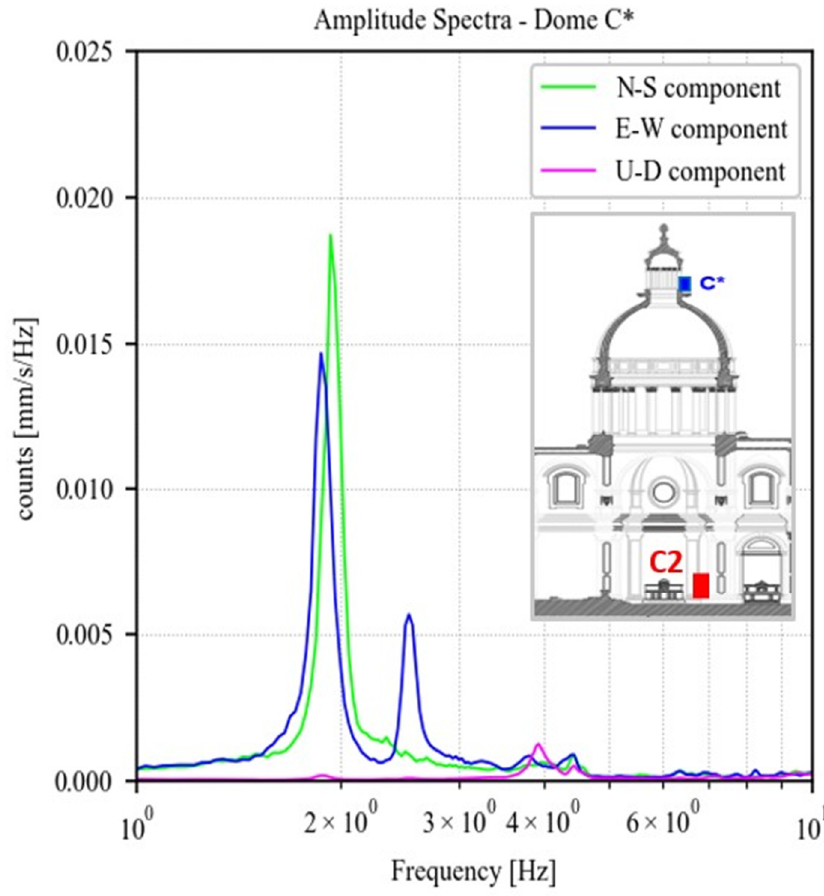
Figure 16. Amplitude of fast Fourier spectra regarding point C* on the top of the dome, for each component (North–South, East–West, Up–Down).